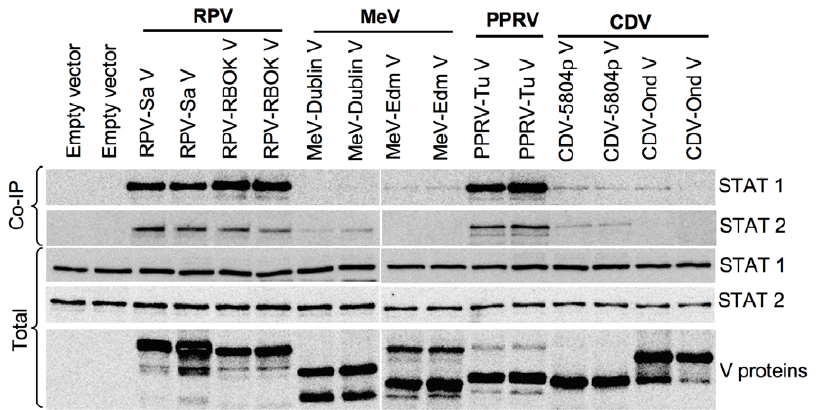
Figure 5. Morbillivirus V proteins show varied abilities to co-precipitate STAT1 and STAT2. Vero human-SLAM cells were transfected in duplicate wells with 1 m g of empty vector or plasmid driving the expression of the indicated protein. Forty-eight hours post-transfection, one member of each pair was lysed with lysis buffer at pH 7.5 and second with lysis buffer at pH 8.0. The lysates were immunoextracted with mouse anti- V5 antibody as in ‘‘Materials and methods’’. The immunoprecipitates (Co-IP) and a fraction of total cell lysate (1/10th) were analyzed in Western blots for the presence of STAT1 or STAT2 using rabbit anti-STAT1 and rabbit anti-STAT2 antibodies respectively. The blots from total cell lysates were also probed with mouse anti-V5 antibody for analyzing the expression levels of the expected V proteins. The primary antibodies were detected with peroxidase-labelled anti-mouse or anti-rabbit IgG antibody. doi:10.1371/journal.pone.0057063.g005 Fig. 5, the difference in pH had very little effect on STAT1/2 co- precipitation, except to reduce the co-precipitation of STAT1 with CDV-Ond V at pH 8.0.